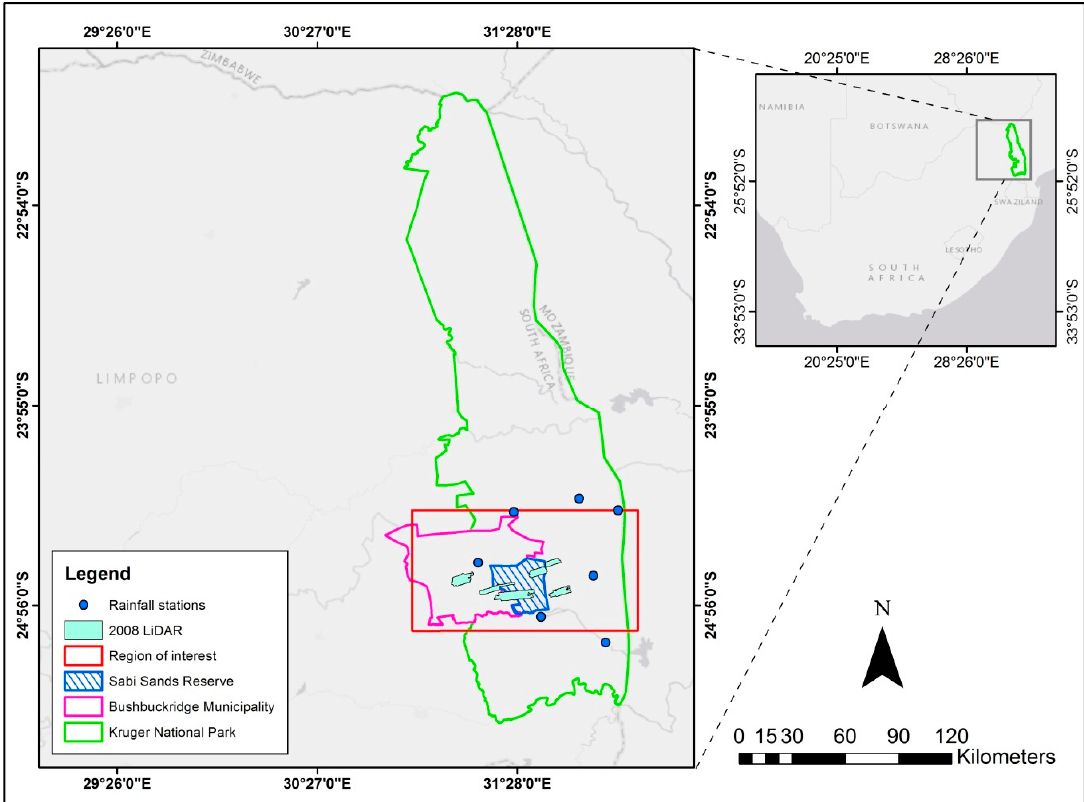
Figure 1. Study area map of the Lowveld region of South Africa, with three land uses (i.e., Sabi Sands private nature reserve, Bushbuskridge communal rangelands, and the Kruger National Park), the LiDAR acquisitions, rainfall stations, and region of interest displayed.